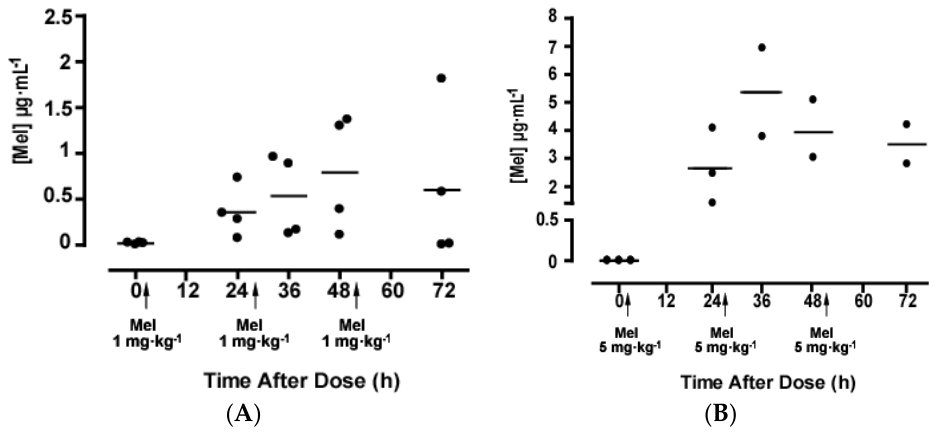
Figure 2. Plasma melatonin concentrations in preterm neonates after repeated melatonin administration. Melatonin was administered at a dose of 1 mg·kg − 1 ( A ) or 5 mg·kg − 1 ( B ), and the administration was repeated after 24 and 48 h. Plasma melatonin concentrations were measured immediately before ( T = 0) and 24, 36, 48 and 72 h after the first administration.